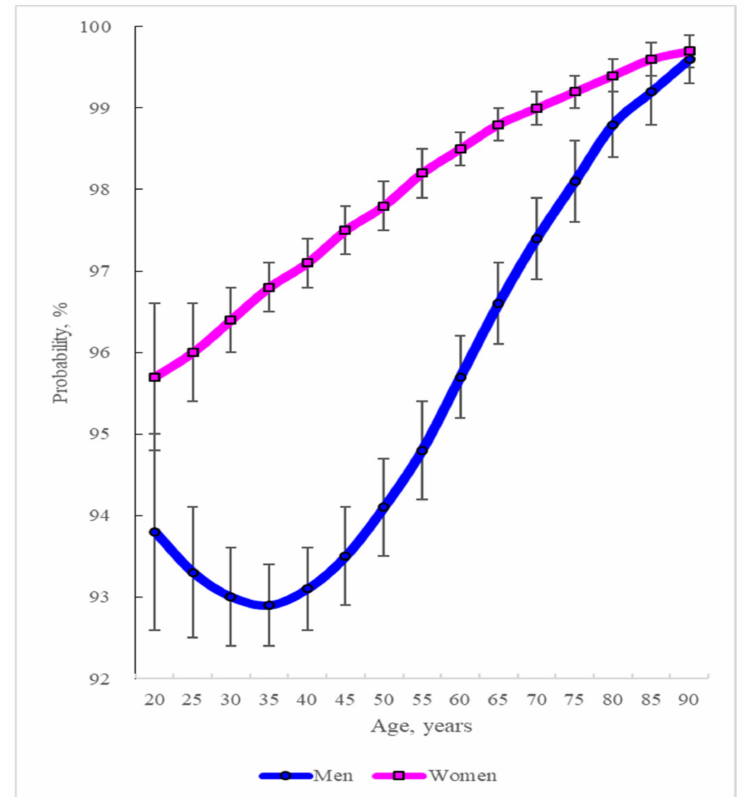
Figure 1. Change in the average adjusted probability (and its 95% confidence interval) of people’s experience of healthcare needs across different age groups by gender. Source: The Korea Health Panel survey data